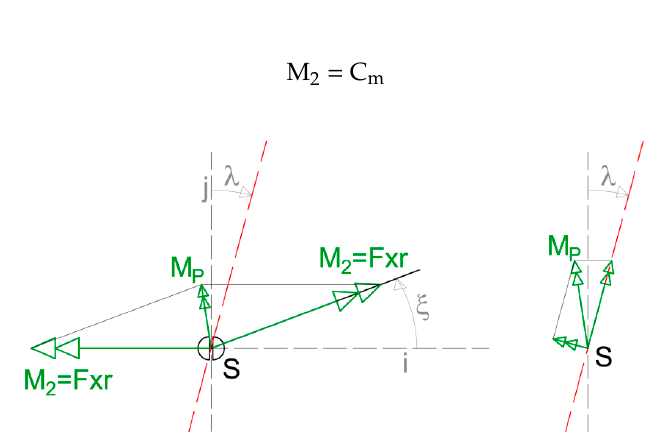
Figure 6. Power balance and secondary